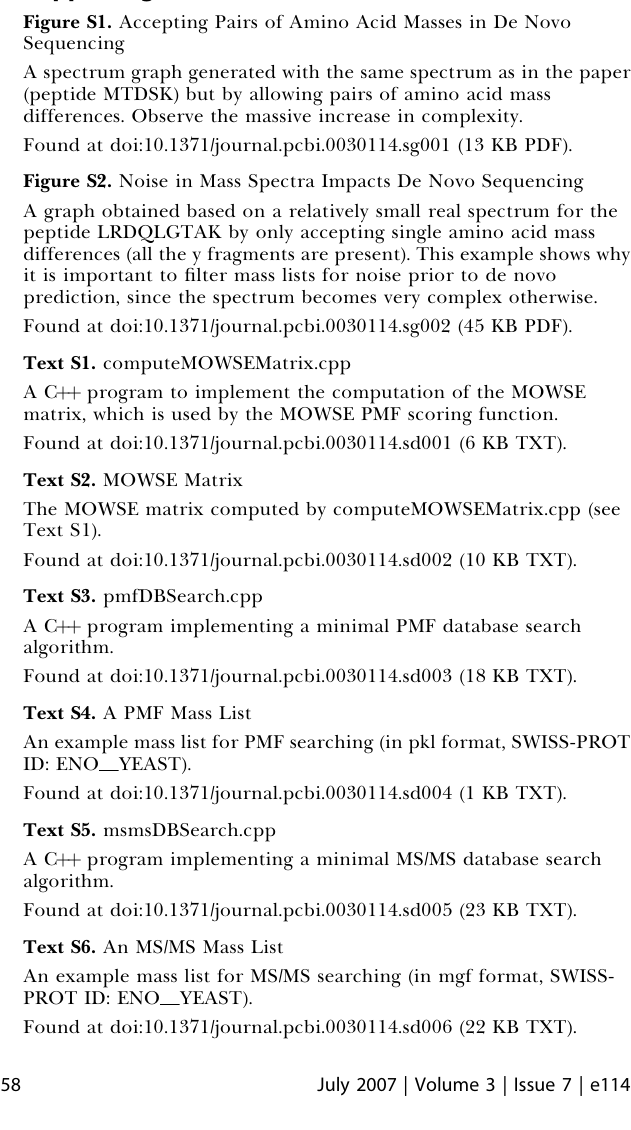
Figure S1. Accepting Pairs of Amino Acid Masses in De Novo Sequencing A spectrum graph generated with the same spectrum as in the paper (peptide MTDSK) but by allowing pairs of amino acid mass differences. Observe the massive increase in complexity. Figure S2. Noise in Mass Spectra Impacts De Novo Sequencing A graph obtained based on a relatively small real spectrum for the peptide LRDQLGTAK by only accepting single amino acid